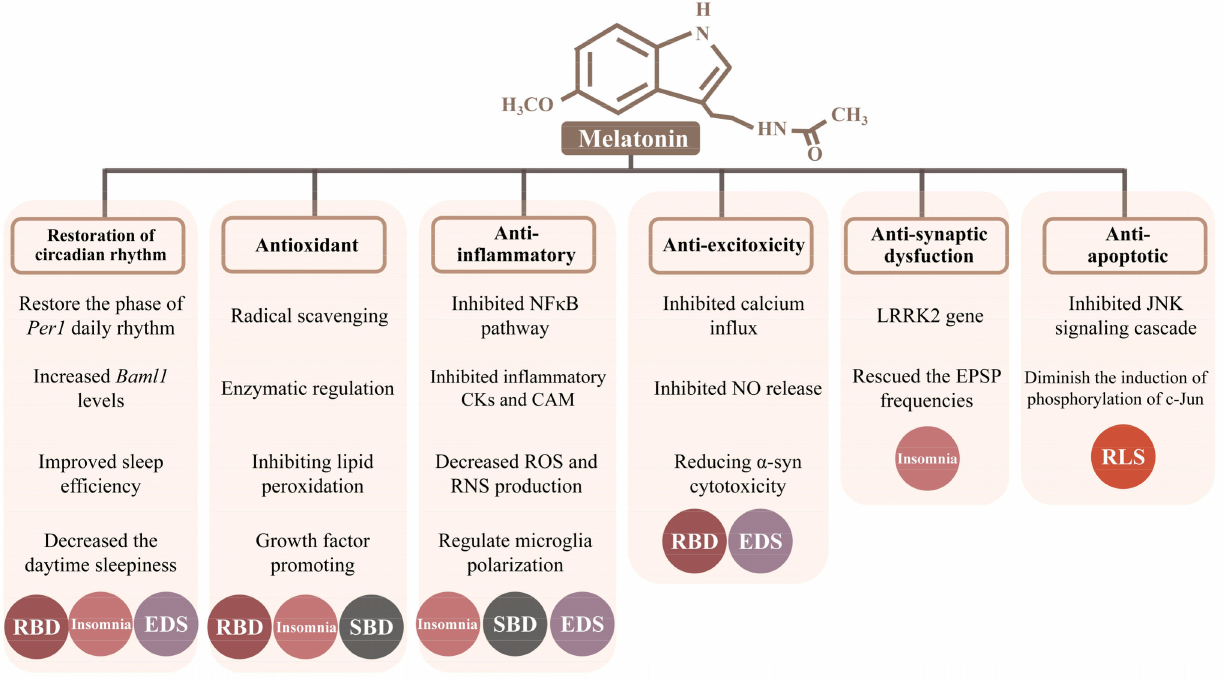
Figure 1. Six possible neuroprotective mechanisms of melatonin therapy for Parkinson’s disease. Noted: N-acetyl-5-methoxytryptamine, melatonin. Opening rectangles under the mechanism repre- sent its involved specific molecular mechanisms, respectively. Different colored circles distinguish five types of sleep disorders. Circles, sleep disorders through the specific mechanisms. Abbreviations: Per1, Period 1; Baml1, brain and muscle aryl-hydrocarbon receptor nuclear translocator-like 1; CKs, cytokines; CAM, cell adhesion molecule; ROS, reactive oxygen species; RNS, reactive nitrogen species; α -syn, α -synuclein; LRRK2, leucine-rich repeat kinase2; EPSP, excitatory postsynaptic